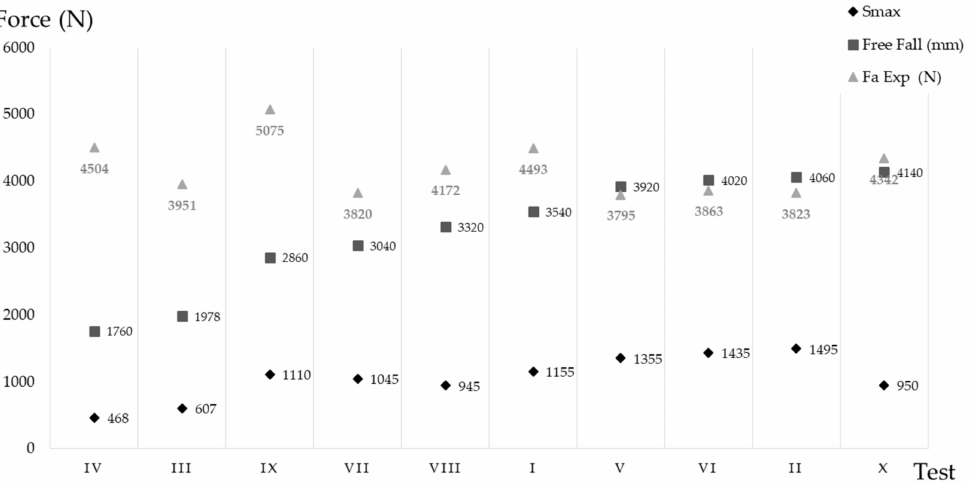
Figure 11. Fa Exp, free fall distance and